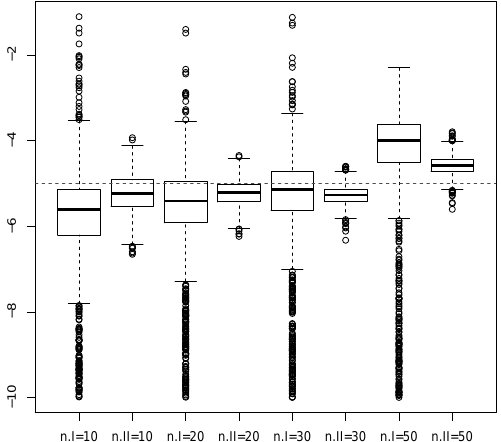
Figure 2. The boxplots of 1000 Bayes estimates of a 1 , where “n.I” and “n.II” indicate that procedures BE-I and BE-II are implemented with sample size n ,